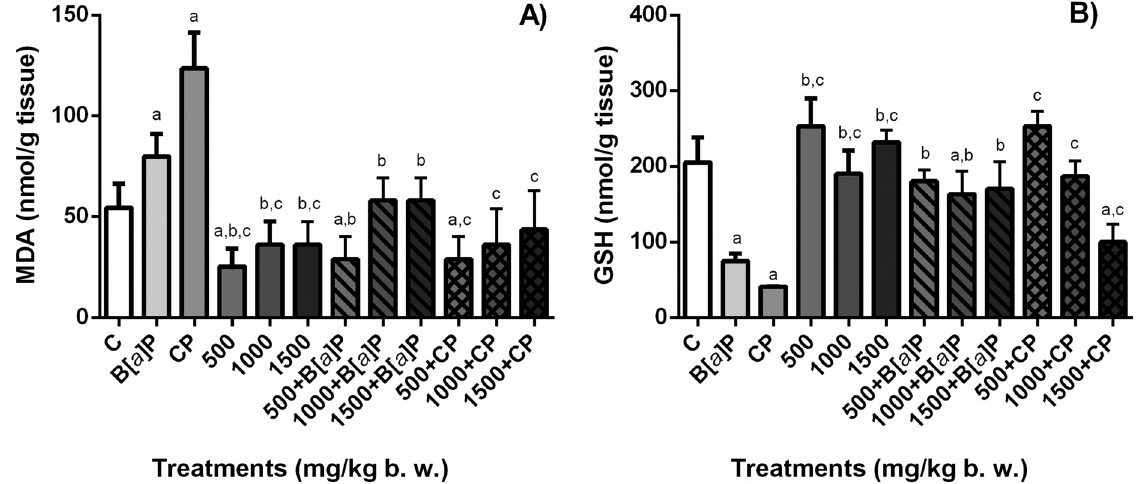
Figure 6 - Quantification of lipoperoxidation by measuring the formation of MDA, principal thiobarbituric acid-reactive specie (TBARS) (A) and GSH (B) in the liver of mouse treated with S. dulcis bark ethanolic extract (500, 1000, and 1500 mg/kg bw) associated or not to the positive controls (B[ a ]P and CP).Resultsareshownasmeans (cid:2) SD. a Statisticallydifferentfromnegativecontrolgroup; b statisticallydifferentfromB[a]Pcontrolgroup; c statistically different from CP control group. MDA: malondialdehyde; GSH: glutathione; C: distilled water; B[ a ]P: benzo[ a ]pyrene; CP: cyclophosphamide. Statisti- cal analysis performed using ANOVA and Tukey’s test with significance threshold of p